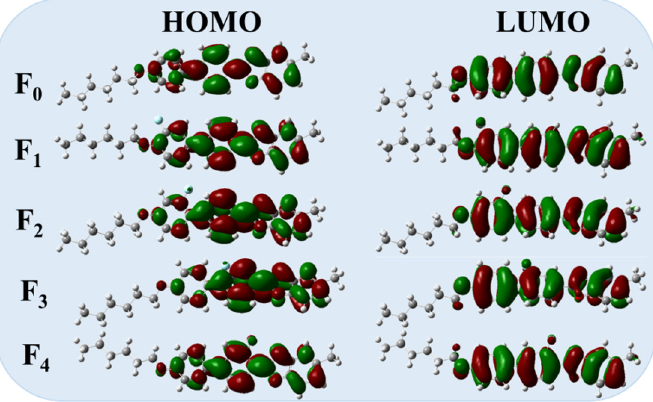
Figure 3. The clearing points of benzoxazole LC compounds and their corresponding LC mixtures.